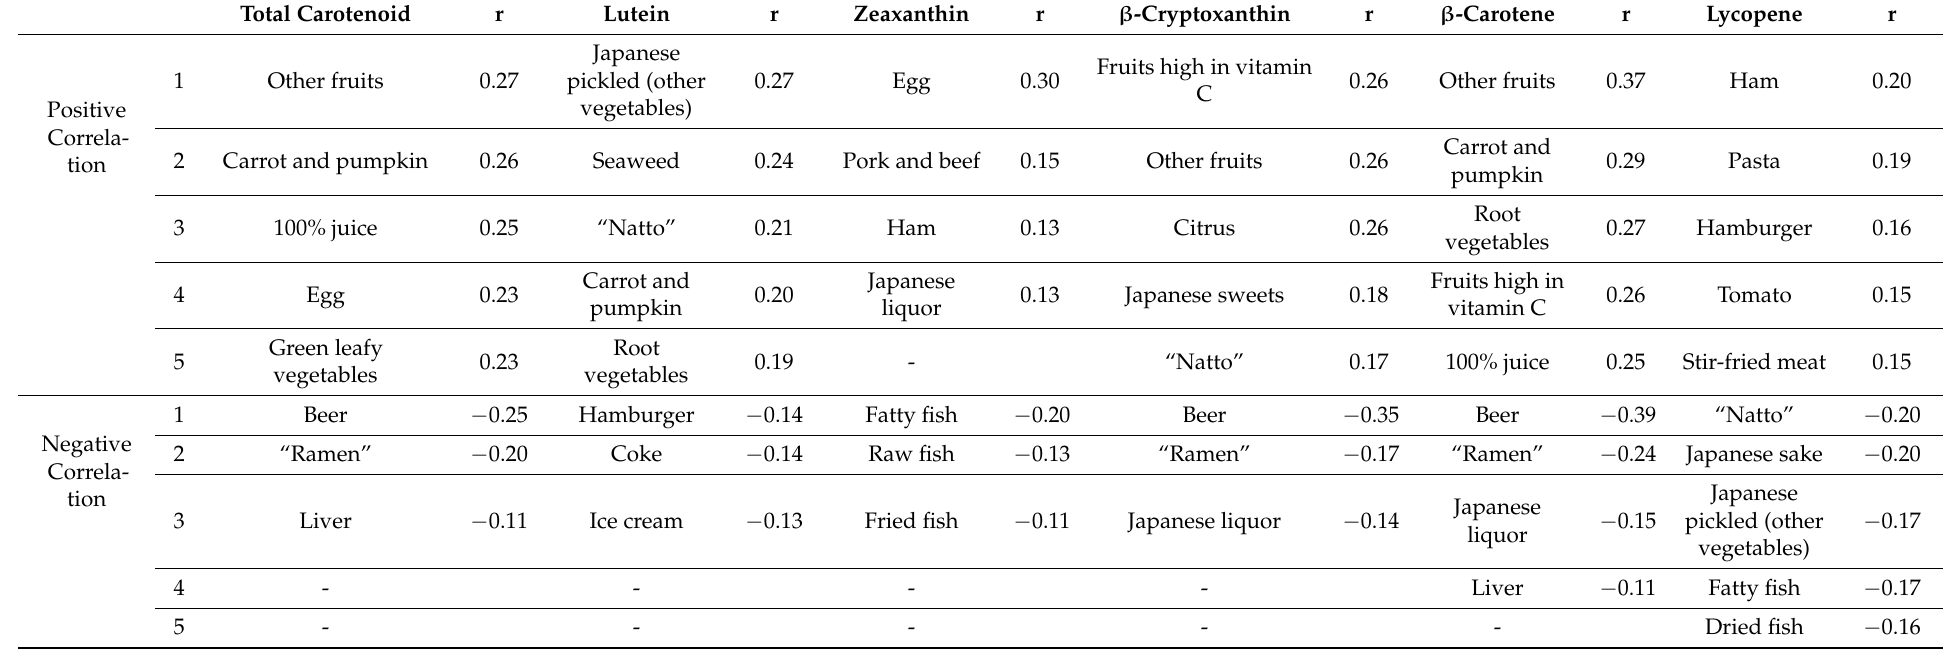
Table 5. Top five food groups that significantly correlated with serum carotenoids in